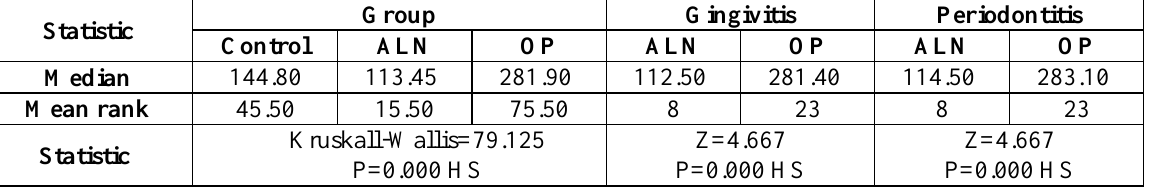
Table 5: The concentration of salivary TNF-α for study and control group with comparison of gingivitis and periodontitis between study groups.